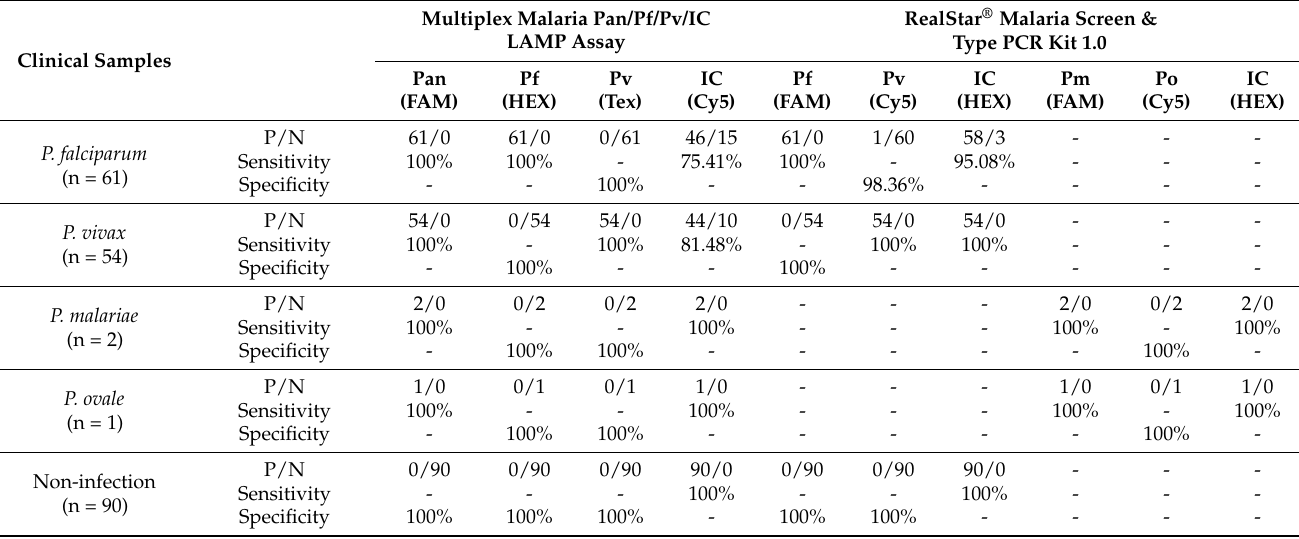
Table 4. Comparison of clinical performance between the multiplex malaria Pan/Pf/Pv/IC LAMP assay and RealStar ® Malaria Screen & Type PCR Kit 1.0 for Plasmodium species ( P. falciparum , P. vivax , P. malariae , and P. ovale ) using clinical